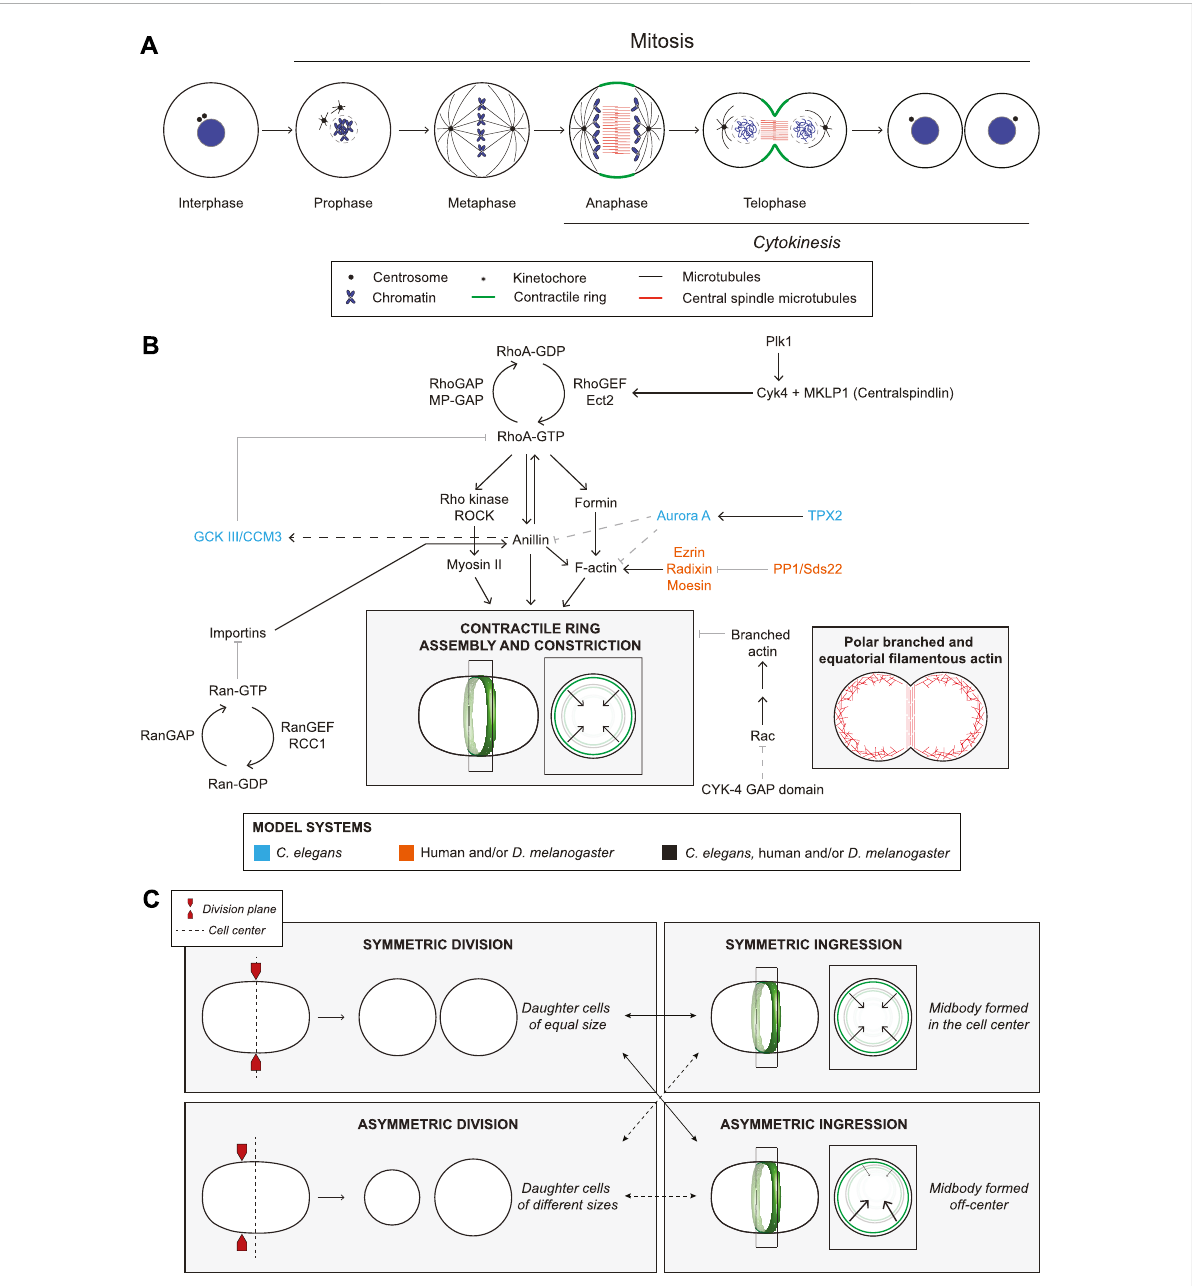
The molecular regulation of ring assembly and constriction. (A) The cartoon schematic shows a cell undergoing mitosis. Chromosome condensationandnuclearenvelopebreakdownoccurduringprophase.Inmetaphase,centrosomes(blackcircles)formabipolarspindle(black)that aligns the sister chromatids (blue). During anaphase, the central spindle forms, consisting of anti-parallel bundled microtubules (red). A contractile ring (green) assembles between the segregating chromosomes and in a plane that bisects the central spindle. During telophase, the ring constricts to divide the cytosol, and the nuclear membrane reassembles. After the ring ingresses, a midbody forms that controls abscission to separate the two daughter cells. (B) Multiple proteins regulate cytokinesis as indicated by the arrows (solid lines are established interactions, while dashed lines are hypothetical). These pathways culminate in the assembly and constriction of an actomyosin ring (cartoon cell, ring in green). To the right, another cell shows the location of polar, branched F-actin (red branches) and linear F-actin (red lines) during cytokinesis. Font colors indicate whetherstudieswereperformedin C.elegans (blue),humancellsand/or D.melanogaster (orange),orallthree(black). (C) Cartoonschematicsshow cells undergoing symmetric division (top left), where two daughter cells of equal sizes are generated, and an asymmetric division (bottom left) forming daughter cells of different sizes. In either type of division, the ring can ingress symmetrically (top right) or asymmetrically (bottom right) where there is more ‘ pull ’ , from one side of the